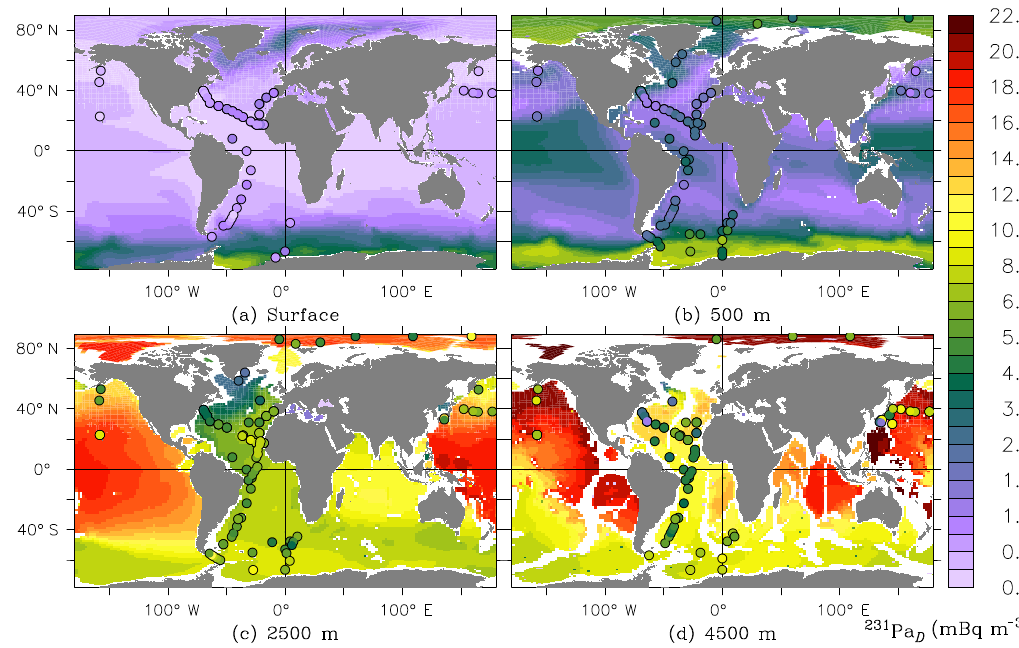
Figure 7. The dissolved protactinium-231 activity at four depth levels (mBqm − 3 ); observations as coloured discs.